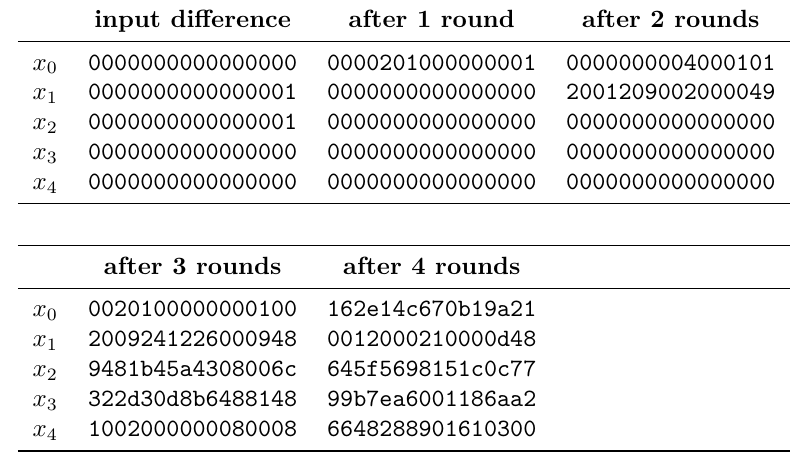
) is [2 , 6 , 32 , 107]. 2